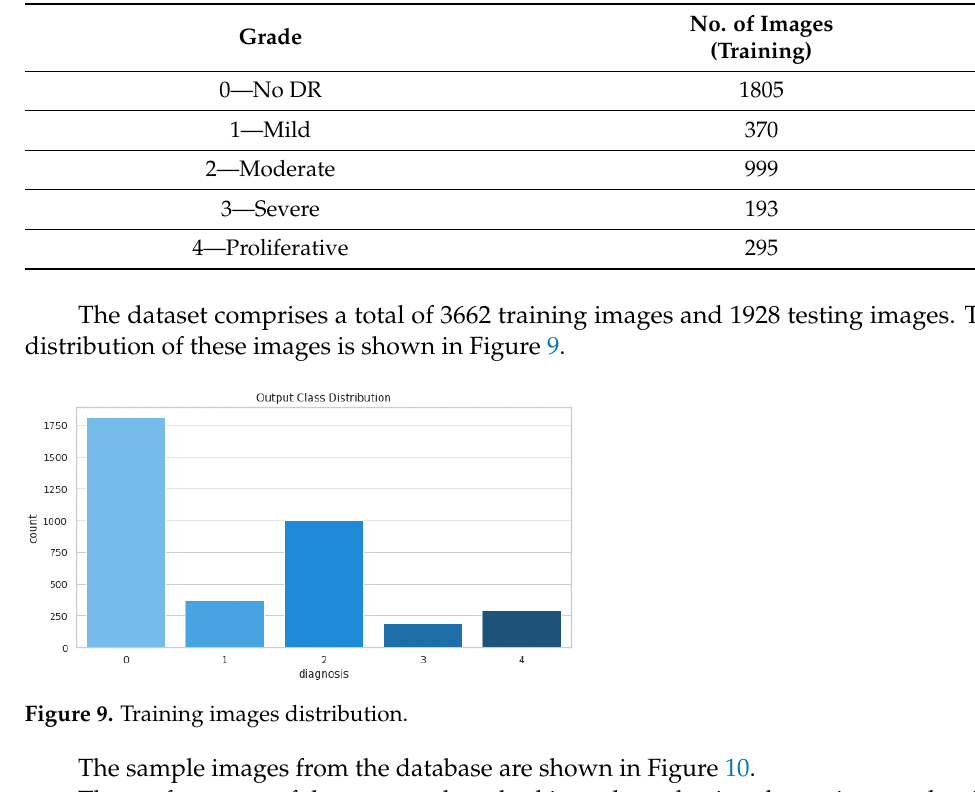
Table 2. Distribution of training images.